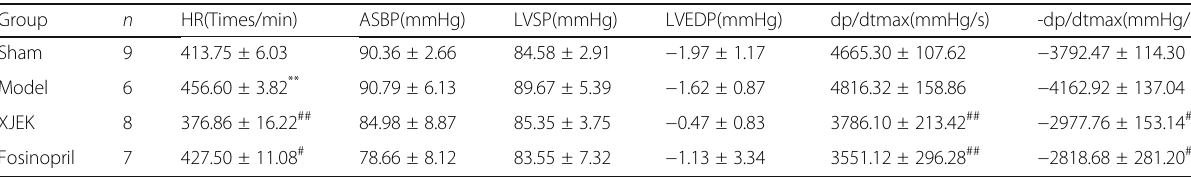
Table 3 Effects of XJEK on cardiac function of MI mice (mean ± SEM) Group